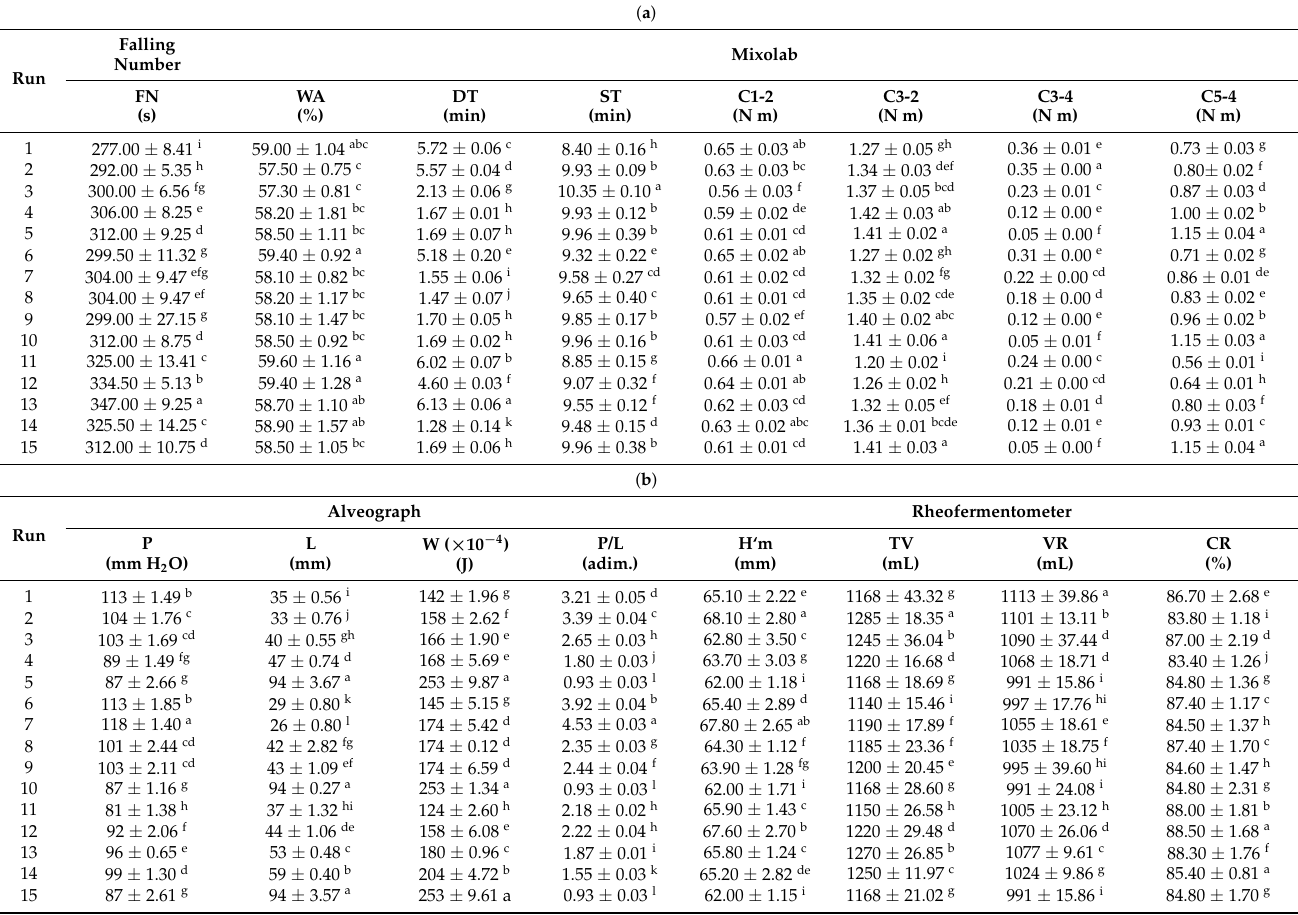
Table 1. Effects of PS and QF addition level on: ( a ) falling number and dough Mixolab parameters, ( b ) Alveograph and Rheofermentometer parameters, ( c ) dynamic rheology and bread characteristics. ( a